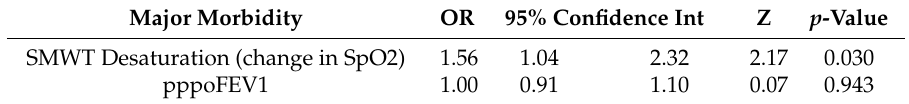
Table 3. Multivariable logistic regression of factors associated with postoperative major morbidity (n = 50). Major Morbidity OR 95% Confidence Int Z p -Value SMWT Desaturation (change in SpO2) 1.56 1.04 2.32 2.17 0.030 pppoFEV1 1.00 0.91 1.10 0.07